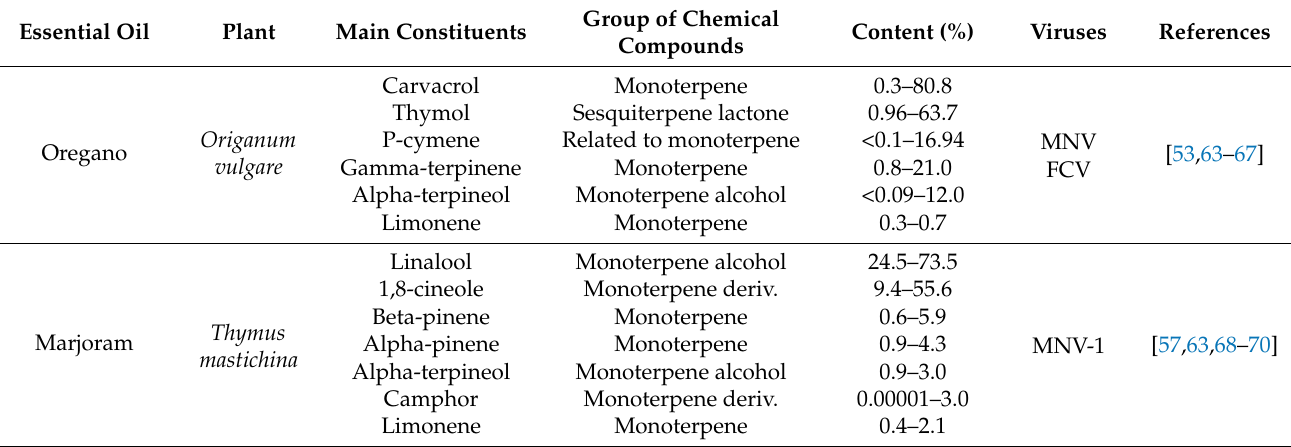
Figure 2. Antiviral activity of metabolites of plant origin against noroviruses. Table 1. The composition of essential oils and their antiviral activity against